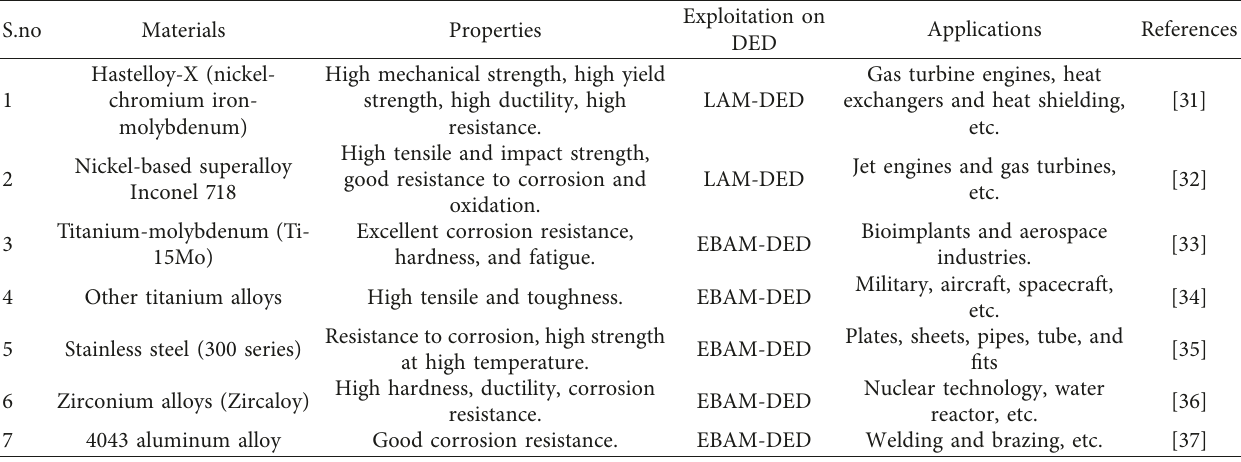
Table 4: Types of feed materials (metal